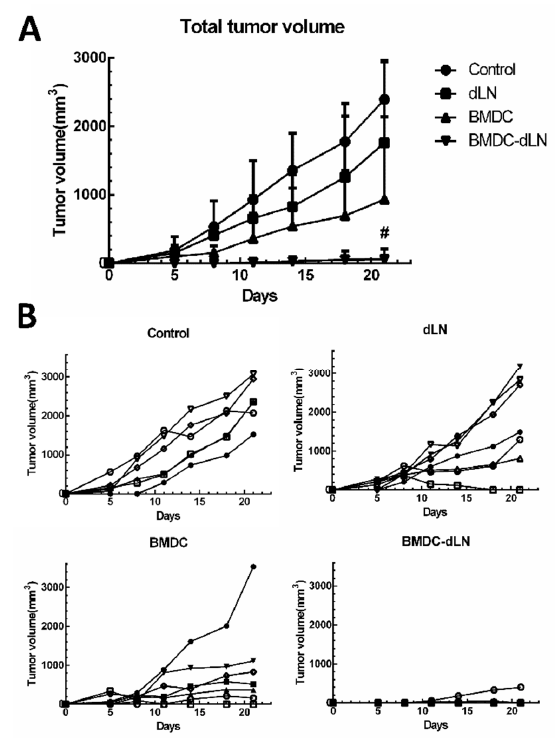
Figure 5. The bone marrow dendritic cell decellularized lymph node (BMDC-dLN) scaffolds rejected tumor growth in mice. ( A ) The average tumor volume of E.G7-OVA tumors in mice. ( B ) The individual tumor growth curves of E.G7-OVA tumors in mice of the phosphate-buffered saline (PBS), dLN, BMDC, and BMDC-dLN groups. (Data are presented as the mean ± SD, #: p < 0.001.).